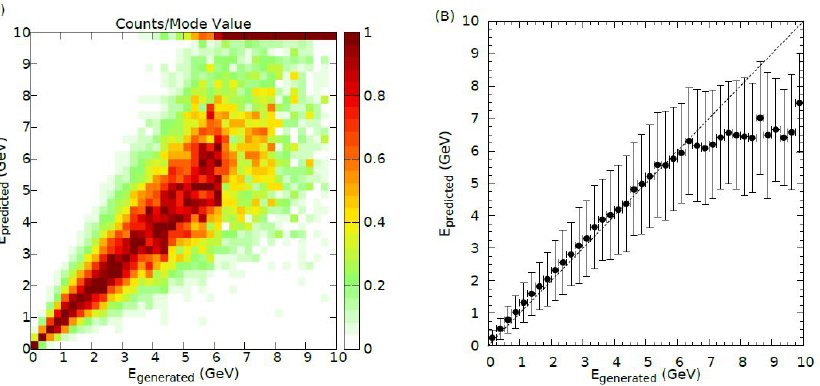
Figure 19. Predicted versus generated muon momentum values from simulated data of the NEWCUT experiment. Reproduced from [115]. ( A ): scatter plot. ( B ): profile histogram; dots indicate the average predicted value, bars its standard